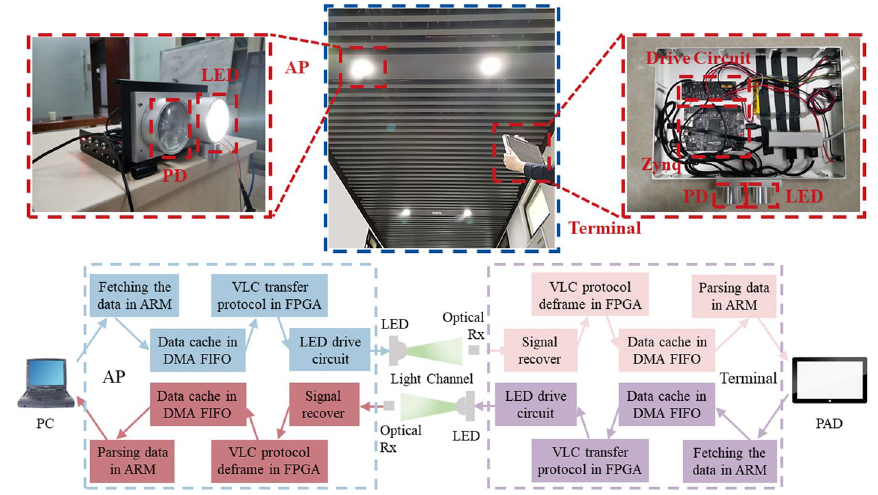
Fig. 5 Block diagram of the experiment setup. The photograph shows the Tx, channel and the Rx. Figure shows internal structure and working principle of the bidirectional VLC system. Blue and pink blocks represent downlink system workflow. Similarly, purple and red blocks represent downlink system